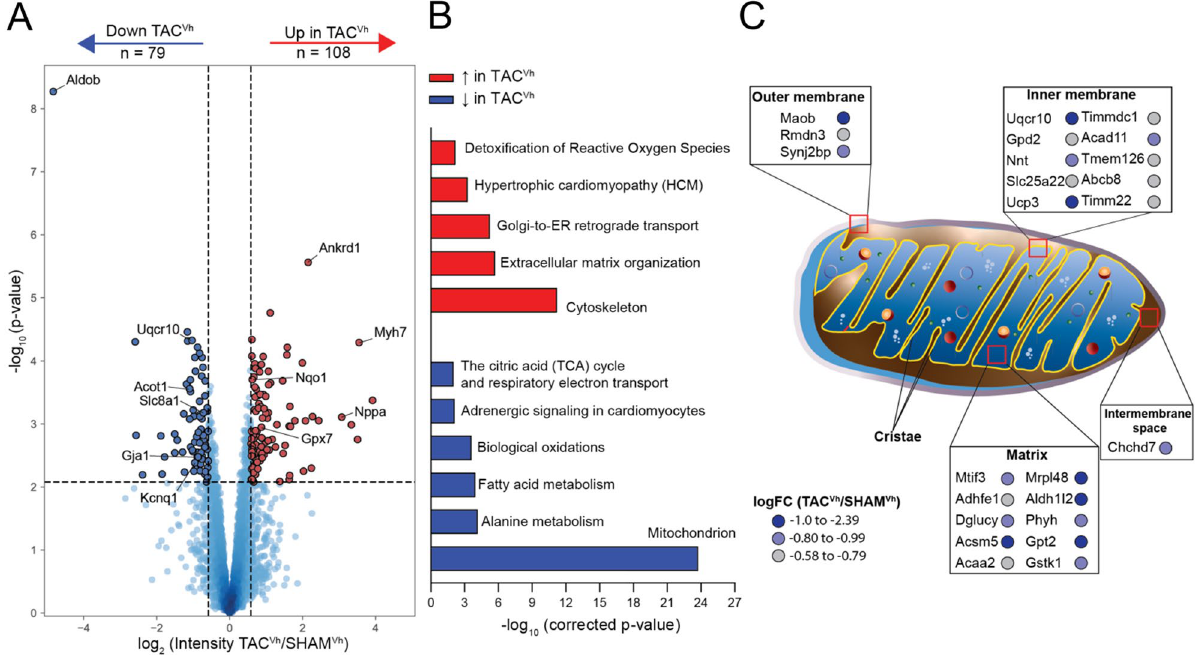
Figure 2. Downregulation of mitochondrial proteins in heart failure. ( A ) Volcano plot analysis of protein abundances in TAC Vh mice compared to SHAM Vh mice. Each point represents a protein, where statistical differences between TAC Vh and SHAM Vh animals were plotted as a function of the log2 transformed protein intensity ratios. Differentially expressed proteins are displayed as upregulated in red, and downregulated in blue. ( B ) Functional enrichment analysis of upregulated (red) and downregulated (blue) proteins in TAC Vh mice compared to SHAM Vh mice evaluated based on GO terms, Reactome and KEGG 68–70 pathway analyses. ( C ) Visual representation of the downregulated proteins in TAC Vh mice with mitochondrial